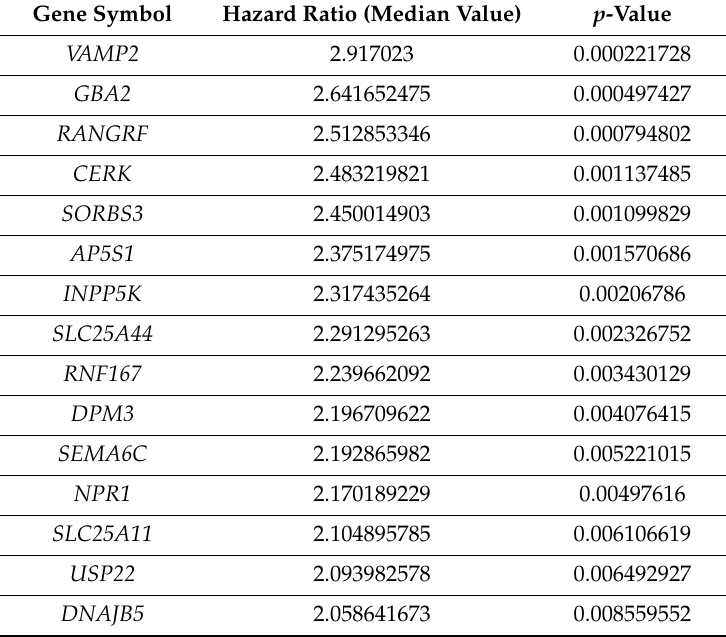
Figure 4. Tree map gene ontology analysis of enhancer CNV associated genes: ( a ) biological process; ( b ) molecular function; and, ( c ) cellular component. Table 1. Cox proportion hazard ratios with p -values of the top 15 genes of enhancer regulated genes; genes sorted based on p